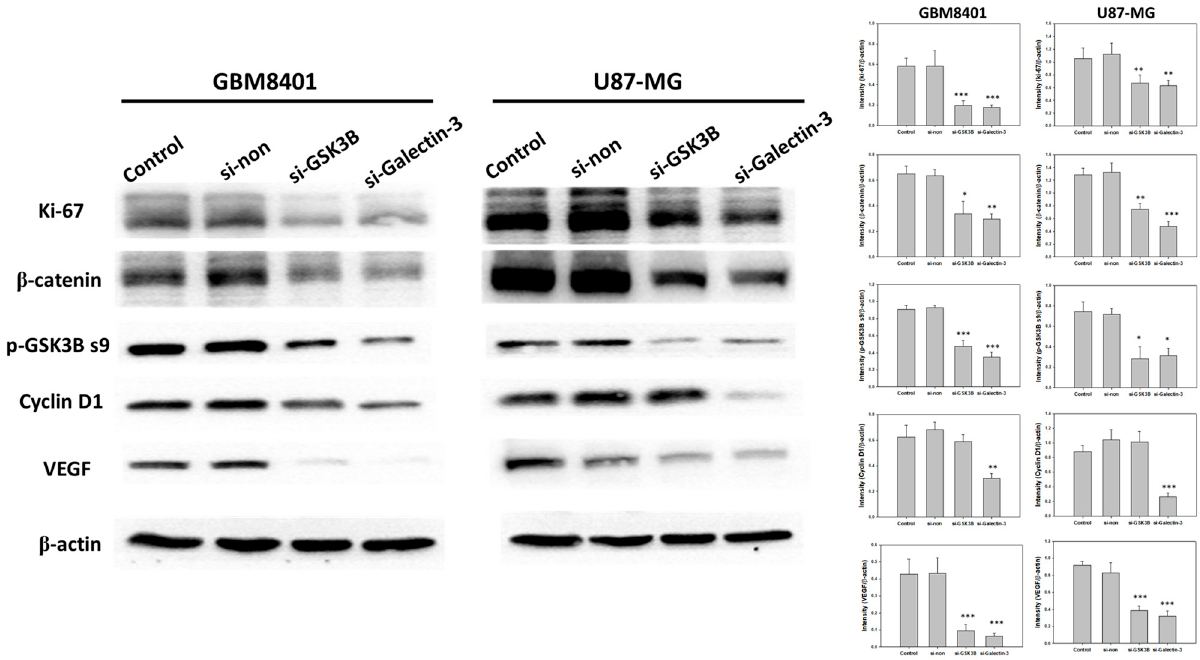
Figure 4. The protein expressions and relative intensity of β -catenin, p-GSK3B ser9, VEGF, Ki-67, and cyclin D1 between control, nonsense siRNA, GSK3B siRNA, and galectin-3 siRNA for 3 days in following transfection with siRNA. ( n = 6). * p < 0.05, ** p < 0.01 and *** p < 0.001 compared with control group.